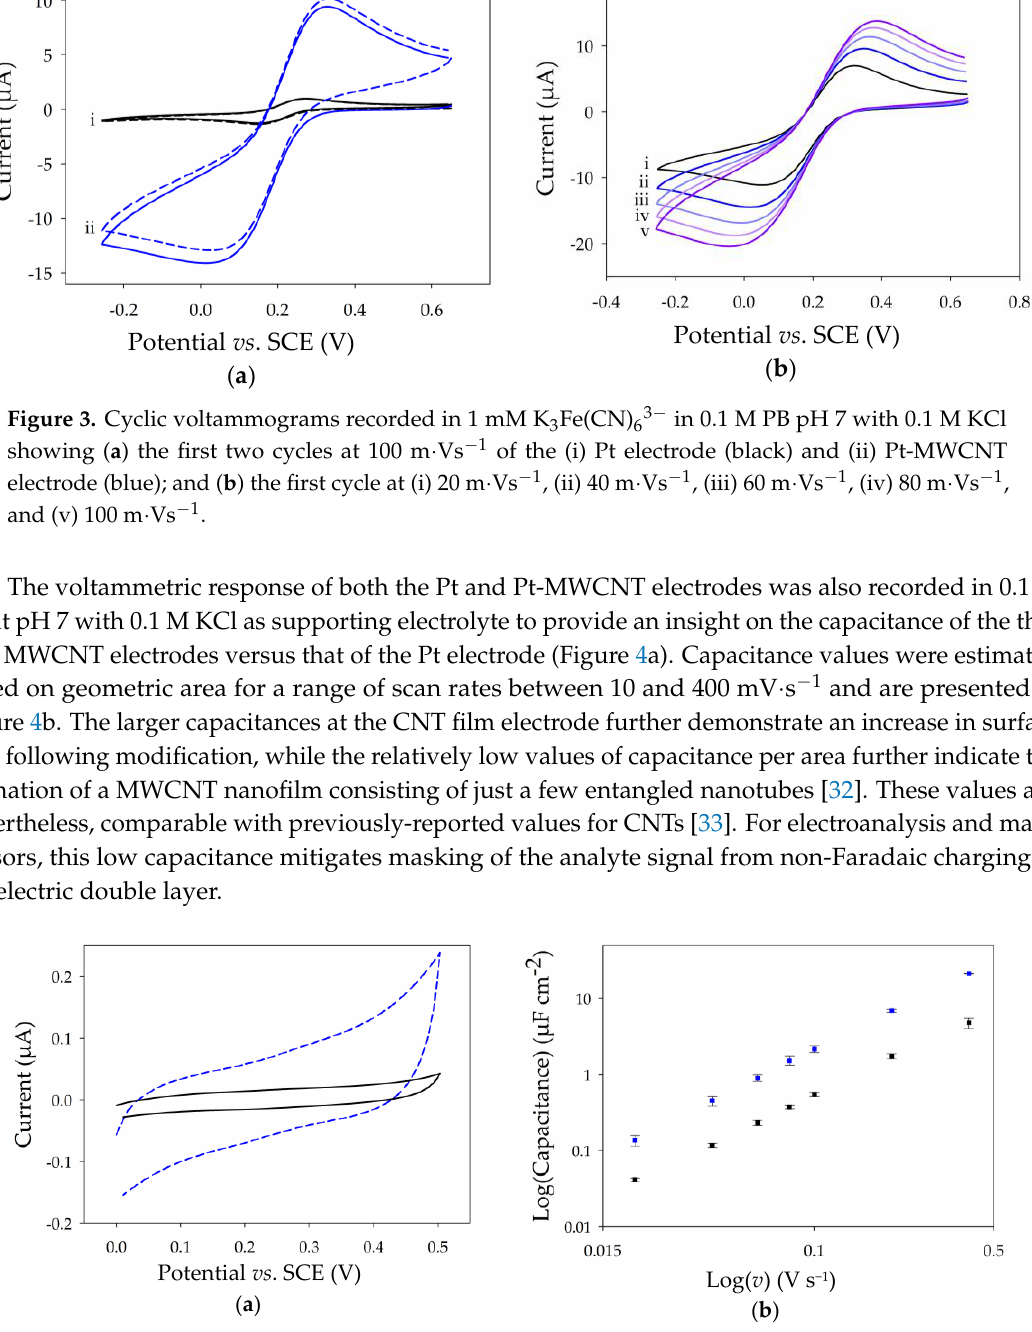
Figure 4. Electrochemical characterization of a planar Pt electrode (solid, black) and a Pt-MWCNT electrode (dash, blue) fabricated using Method A: ( a ) cyclic voltammograms recorded at 100 mV·s −1 in 0.1 M PB at pH 7 with 0.5 M KCl; and ( b ) log-log plot of the capacitance versus scan rate for the Pt electrode (black) and Pt-MWCNT electrode (blue).